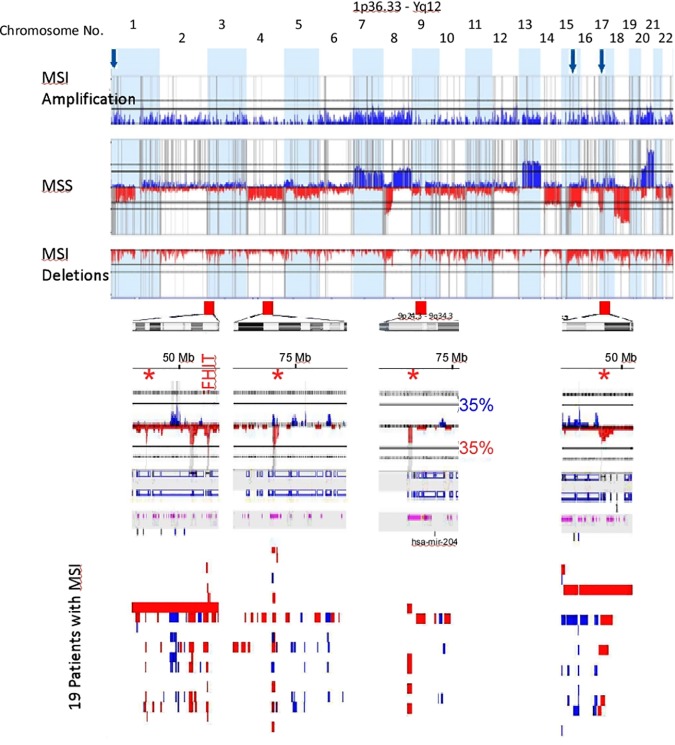
Frequency profiles of copy number aberrations from 89 MSS (middle histogram; with gains above 0% line shown as blue peaks and below 0% as deletions in red) and 19 MSI CRC cases (divided histogram; upper showing gains in blue and lower histogram shows deletions in red).The vertical grey lines indicate significant peaks of copy number alterations. Notice how these peaks align precisely in both MSS and MSI CRC. Copy number aberrations that are private for MSI CRC cases are marked with red arrows for deletions and blue arrows for amplifications. Below each red arrow are the corresponding chromosomal region ideogram and a zoomed histogram focused on the red arrowed region. The histograms show deletions in red and amplifications in blue and significant STAC-generated peaks in grey as stated above. Deletions marked with asterisks correspond to the deletions marked with the red arrows. All these aberrations are not considered in the exported regions because they do not reach the 35% cutoff value (marked horizontal black lines on chromosome 9). Note how the marked FHIT deletion crosses the 35% line. The individual copy number alteration for each patient from 19 MSI cases are shown as small vertical red and blue bars indicating deletions and amplifications respectively. Note how well-demarcated are these recurrent aberrations.